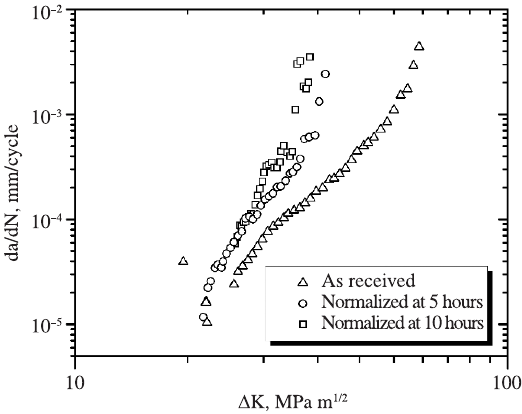
Figure 3. Plot of fatigue crack growth rate as a function of the grain size for the HAZ normalized at 1200 °C for different time periods.